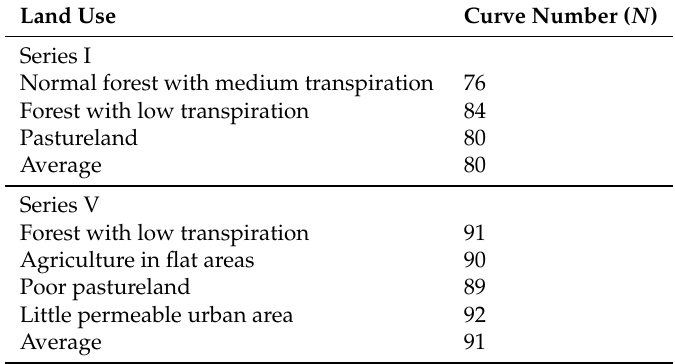
Figure 2. Thematic maps of land use distribution in the basins located upstream of Villahermosa: ( a ) land use of Series I (until 1992); ( b ) land use of Series II (1993–1996); ( c ) land use of Series III (2000–2004); ( d ) land use of Series II (2007–2010); and ( e ) land use of Series II (2011–2013) [1]. Table 2. Correspondence of land use types with their curve number, for SI and